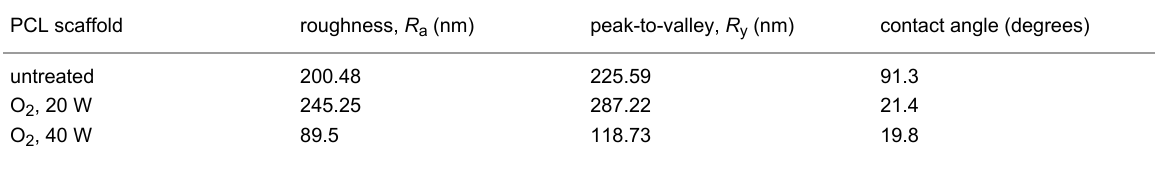
Table 1: Surface characteristics from AFM analysis and water contact angle measurements for the untreated and the O 2 -plasma-treated nanofibrous scaffolds. PCL